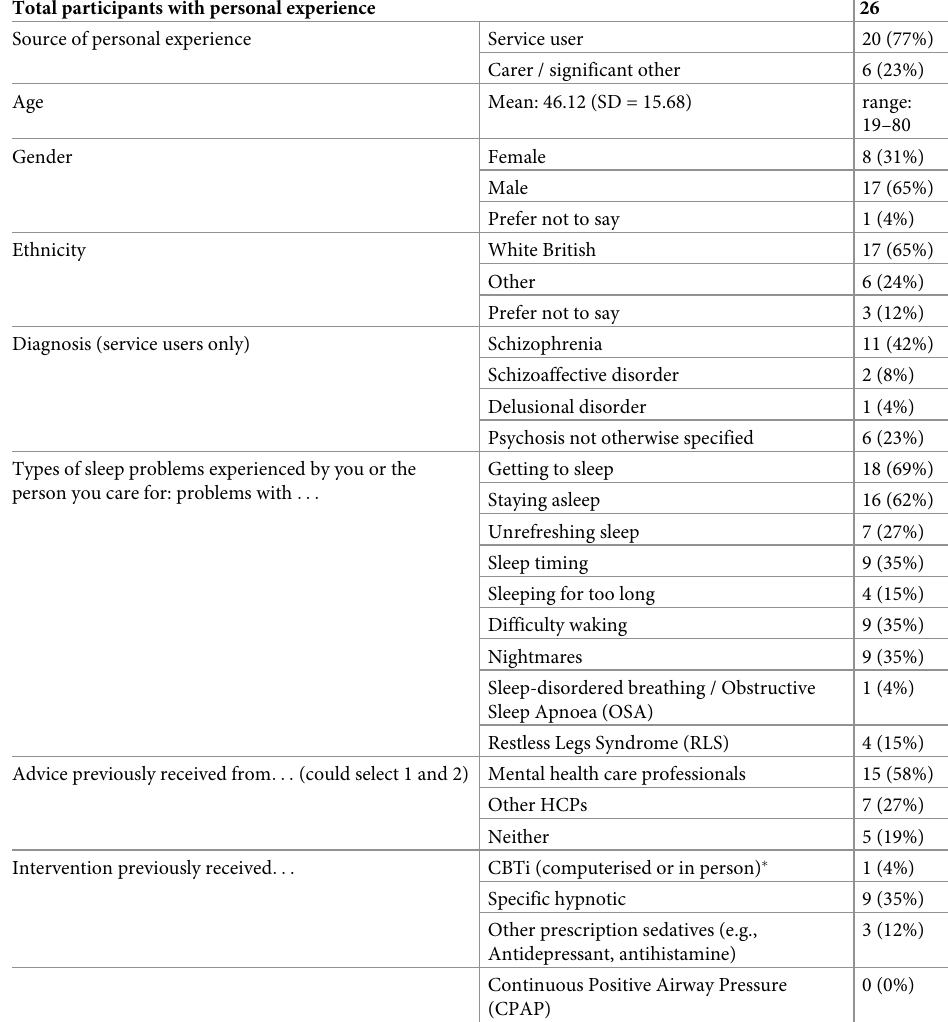
Table 2. Demographic data for participants with personal experience. Total participants with personal